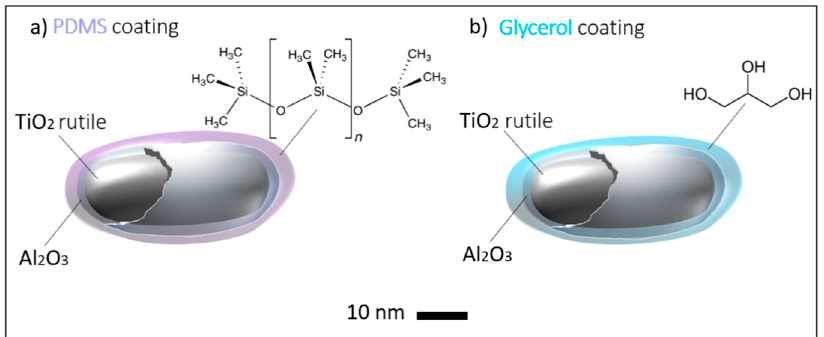
Figure 9. Schematic representation of core–shell Al-coated titania nanoparticles with different types of functionalization layers: ( a ) PDMS coating and ( b ) glycerol coating. The shape of the particles can vary, however, these are not a round shape. For the approximate size estimation, a nanometer scale bar is displayed.